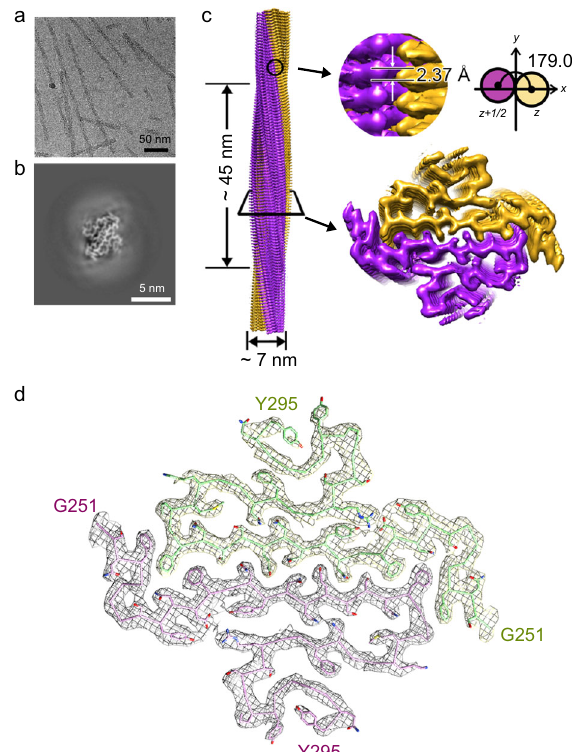
Fig. 1 CryoEM structure determination of the amyloid fi bril formed by hnRNPA1 LC domain. a CryoEM image of the amyloid fi brils formed by hnRNPA1 LC. Fibrils formed by hnRNPA1 LC puri fi ed in four independent experiments provide reproducible images. b CryoEM 3D reconstruction of the hnRNPA1 LC fi bril. c CryoEM density map of the hnRNPA1 LC fi